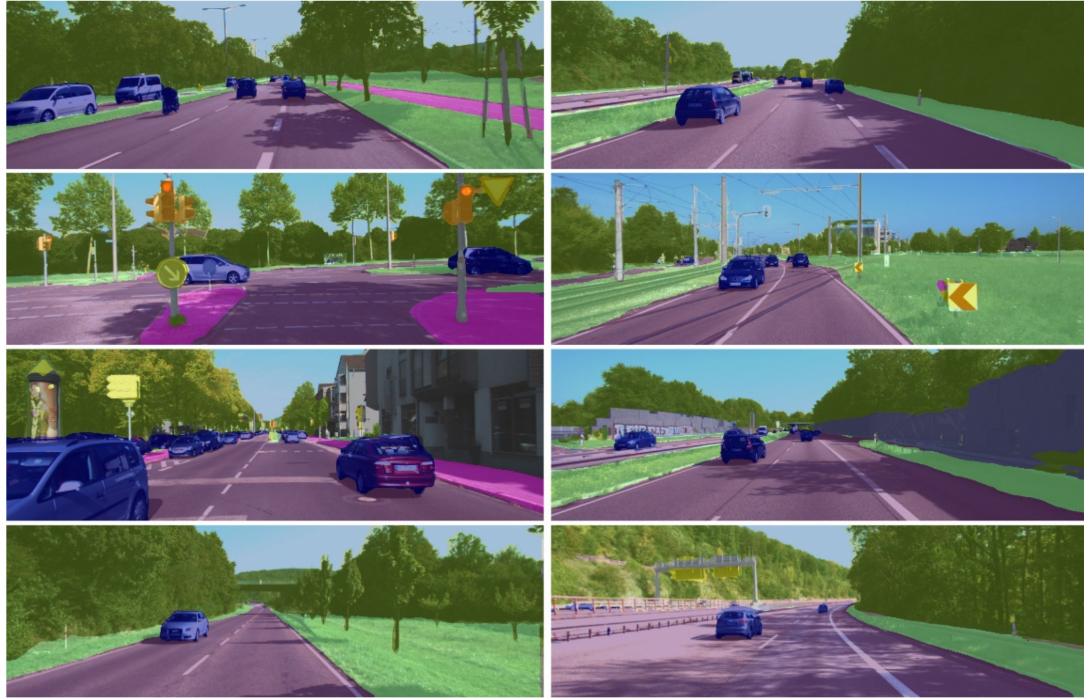
Figure 9. Segmentation results on KITTI dataset.